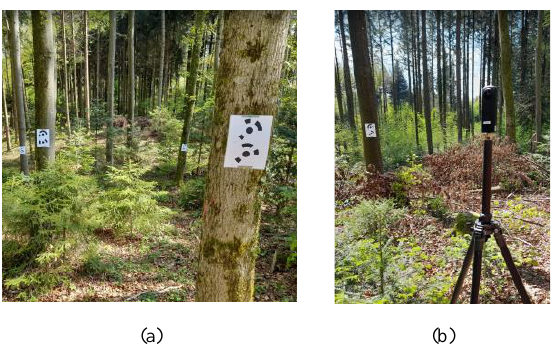
Figure 1. Field setting for data acquisition: (a) automatic coded targets used and (b) the Ricoh Theta Z1 360  camera.